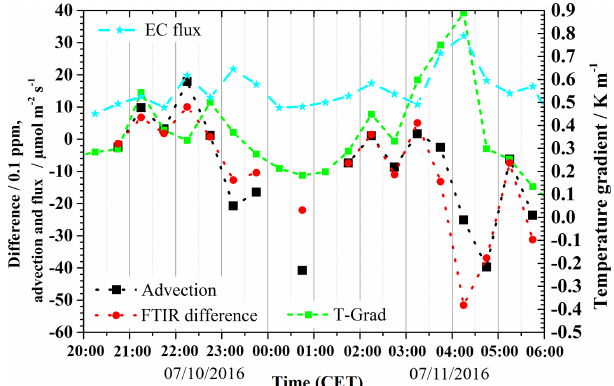
Figure 15. Averaged (30min) spatial difference in CO 2 concentra- tion (OP-FTIR) and horizontal advection (A-TOM, OP-FTIR) at a height of about 1.5m; vertical gradient (3.0–1.5m) of acoustic vir- tual temperature (A-TOM) and CO 2 flux at a height of 3.0m